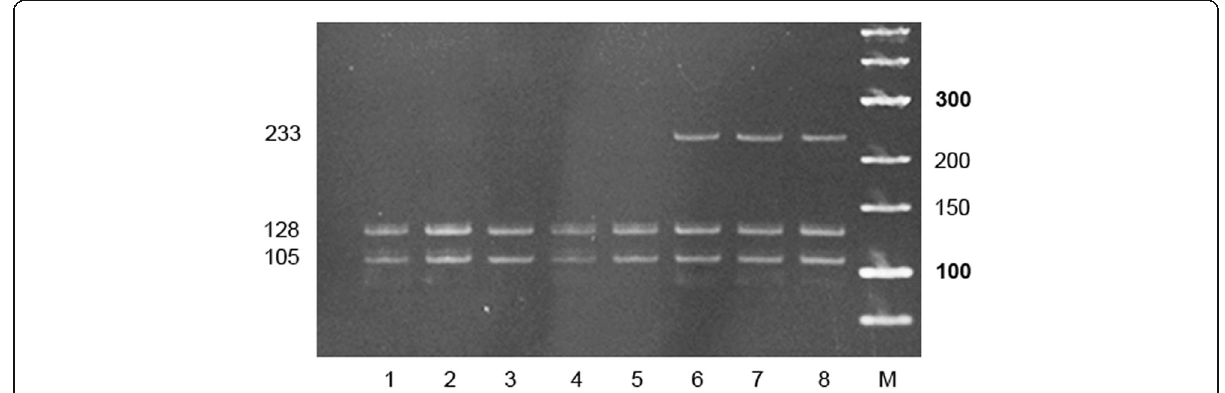
Fig. 3 PCR-RFLP detection of KCNT1 934 codon mutation (c.2800G>A). М — GeneRuler Low Range DNA Ladder (Thermo Fisher Scientific, USA); 1 – 5 — homozygotes by normal allele c.2800G>A (128 and 105 bp DNA fragments length); 6 – 8 — heterozygote genotypes (233, 128, and 105 bp DNA fragments